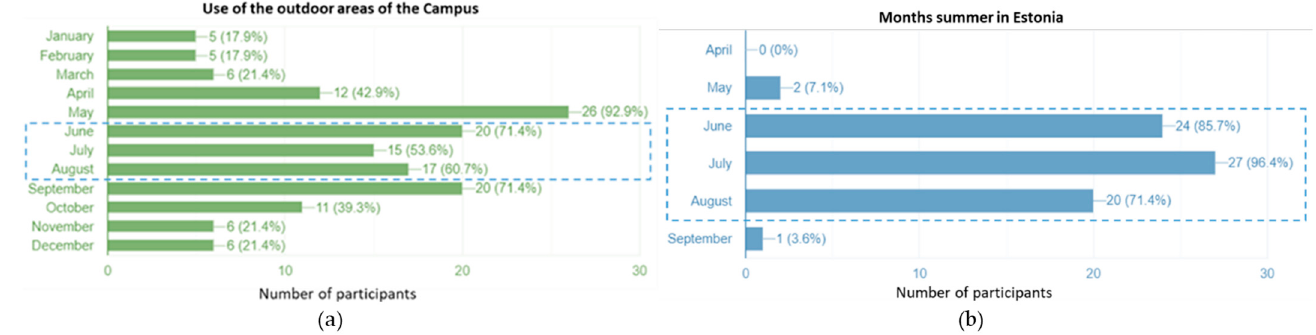
Figure 10. Months in which participants use the Taltech Campus ( a ) and considered summer months ( b ).